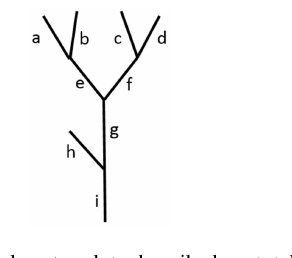
Figure 4. A small sample network to describe how total streamflow is